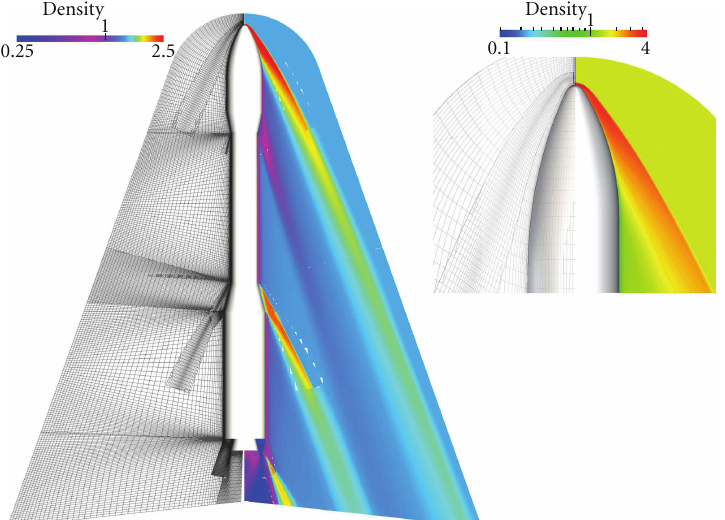
Figure 5: Launcher Vega: overlapping grid and density contours in the symmetry plane; global view and detail of the nose region.